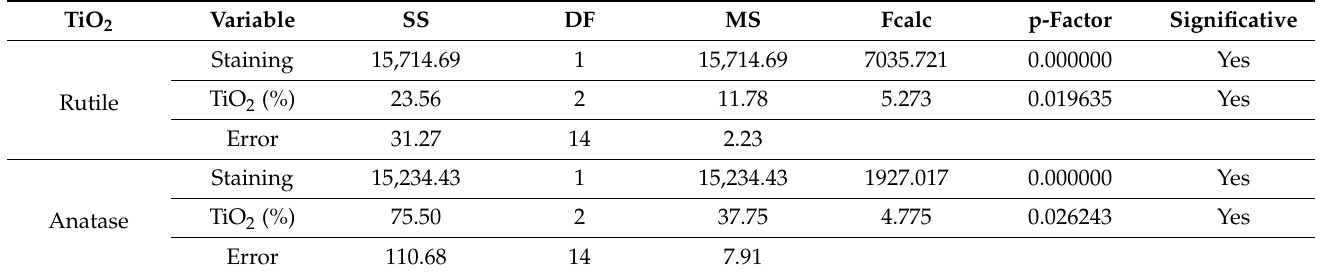
Table 4. Main effects analysis of variance for tiles produced with TiO 2 rutile and anatase, with and without methylene blue staining, cured in an urban environment over